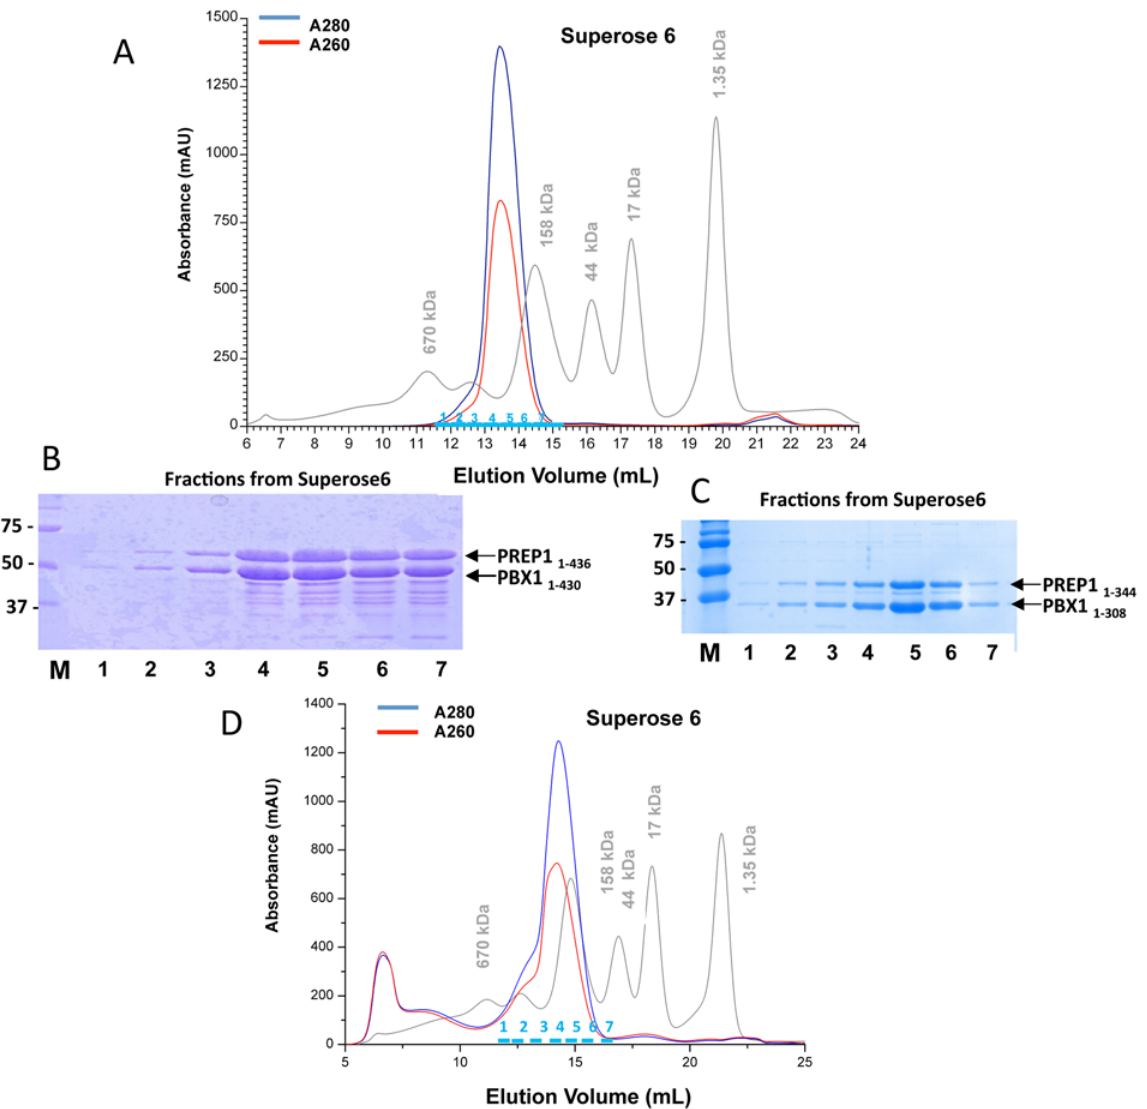
Fig 4. Gel filtrations of full-length PBX1:PREP1 and PBX1 1 – 308 :PREP1 1 – 344 complexes. A. Size exclusion chromatography on a Superose 6 10/300 column of the full-length PBX1:PREP1 complex purified by anion exchange chromatography. Markers were thyroglobulin (M r 670,000), bovine gamma globulin (M r 158,000), chicken ovalbumin (M r 44,000), equine myoglobin (M r 17,000), and vitamin B 12 (M r 1,350). B. SDS PAGE of fractions from full-length PBX1:PREP1 gel filtration. Lane M, Bio-Rad size standard; lanes 1 – 7, fractions indicated in cyan in the above chromatogram; fractions volume was 0.5 ml, and on SDS PAGE were loaded 10 μ l of each fraction C. SDS PAGE of fractions from PBX1 1 – 308 :PREP1 1 – 344 gel filtration. Lane M, Bio-Rad size standard; lanes 1 – 7, fractions indicated in cyan in the chromatogram below; fractions volume was 0.5 ml, and on SDS PAGE were loaded 10 μ l of each fraction D. Size exclusion chromatography on a Superose 6 10/300 column of the truncated PBX1 1 – 308 :PREP1 1 – 344 complex purified by cation exchange chromatography. Markers were as in panel